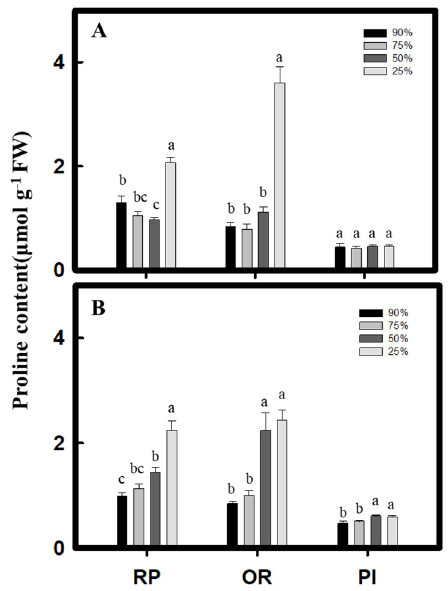
Figure 5. Effect of drought stress on proline content in C. formosana and C. quinoa . C. formosana RP variety, OR variety, and C. quinoa PI variety grow to vegetative stage ( A ) and reproductive stage ( B ); the proline content was investigated, respectively. Bars show means ± SE. Values with the same letter are not significantly different in treatments between the same variety by LSD ( p < 0.05, n = 4).